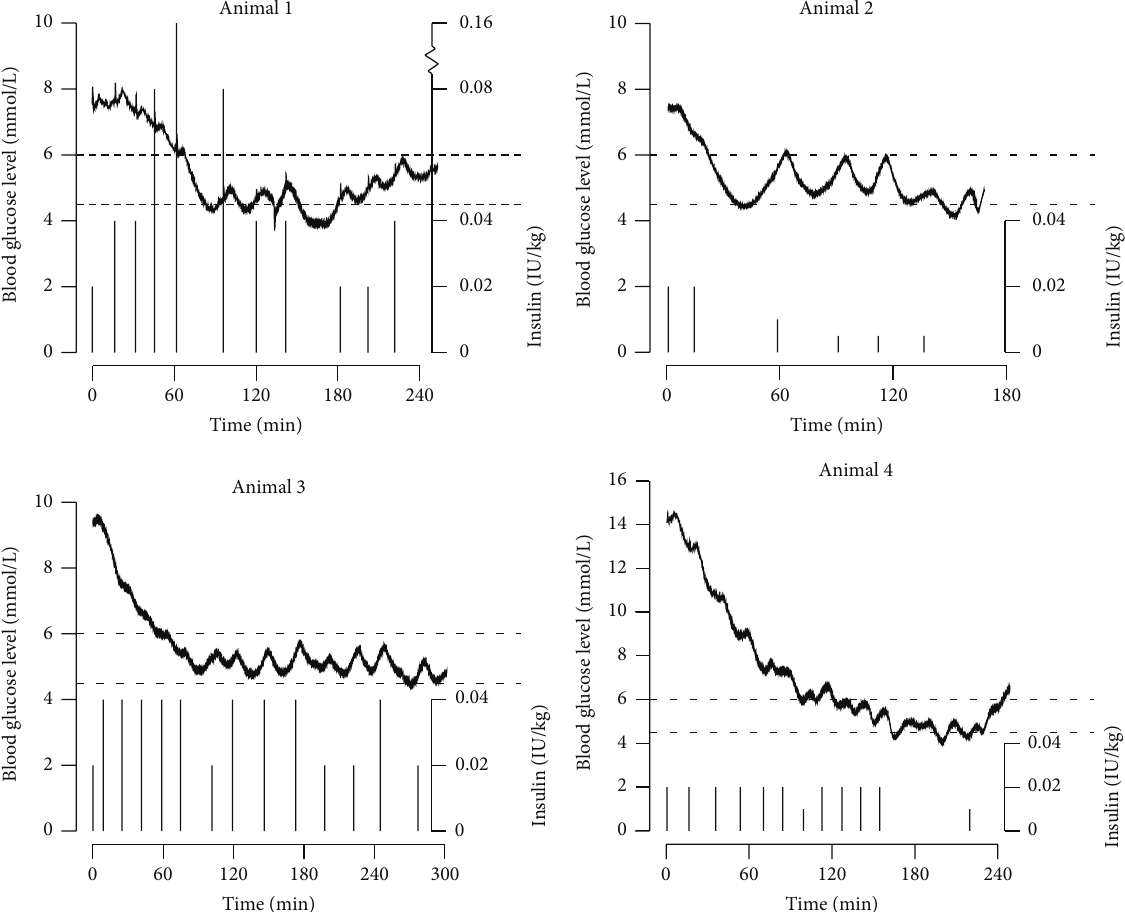
Figure 3: Blood glucose control in four animals; the curves depict the blood glucose level, the histograms depict the insulin boluses, and the horizontal dashed lines depict the ideal blood glucose target interval of 4.5 to 6.0mmol/L. Table 1: The seven outcome variables from the four animals; BGL lowest blood glucose level recording during the experiment; 𝑇 glucose level went below 6.0mmol/L; RD: the rate of blood glucose level decrease during 𝑇 glucose level went below 6.0mmol/L until end of experiment; 𝑇 percentage time with BGL in the correct range between 4.5 and 6.0 mmol/L during 𝑇 Animal BGL 0